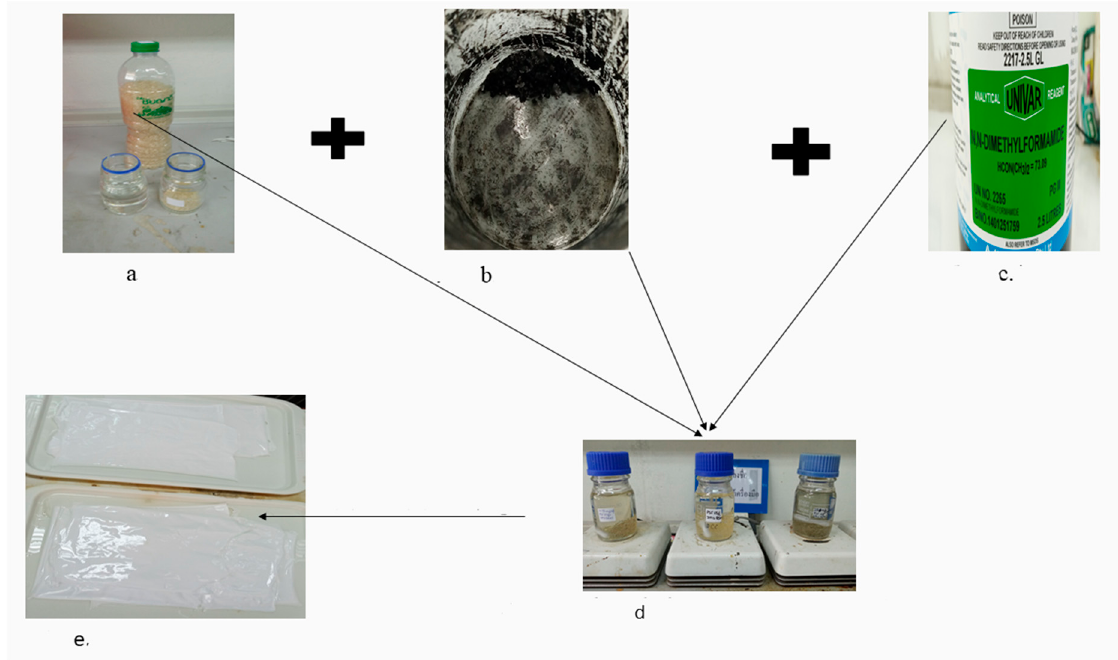
Figure 2. Membrane preparation ( a ) Polysulfone ( b ) r-GO Powder ( c ) N,N-dimethyl formamide (DMF) ( d ) Stirring the solution over night at room temperature and ( e ) Different